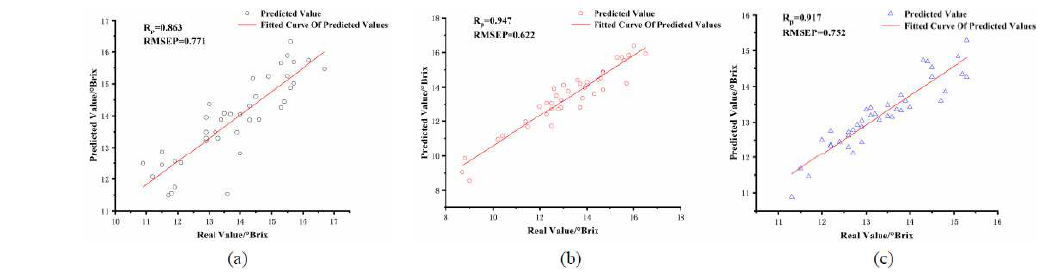
Figure 3. Scatter plot of PLSR prediction of apple SSC for three apple diameter sets. ( a ) apple size